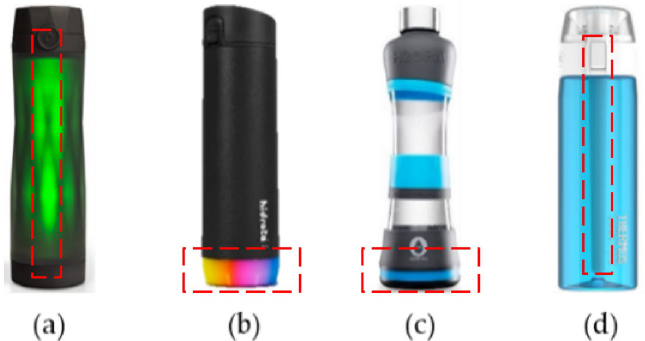
Figure 1. Images of analyzed commercial bottles: ( a ) HidrateSpark 3 4 , ( b ) HidrateSpark Steel 5 , ( c ) H2OPal 6 , ( d ) Thermos Smart Lid 7 . The dashed red boxes show the location of the sensors.